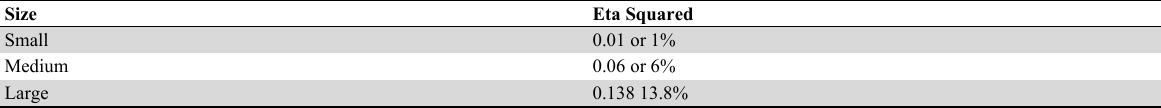
Interpretation of the strength of the eta squared